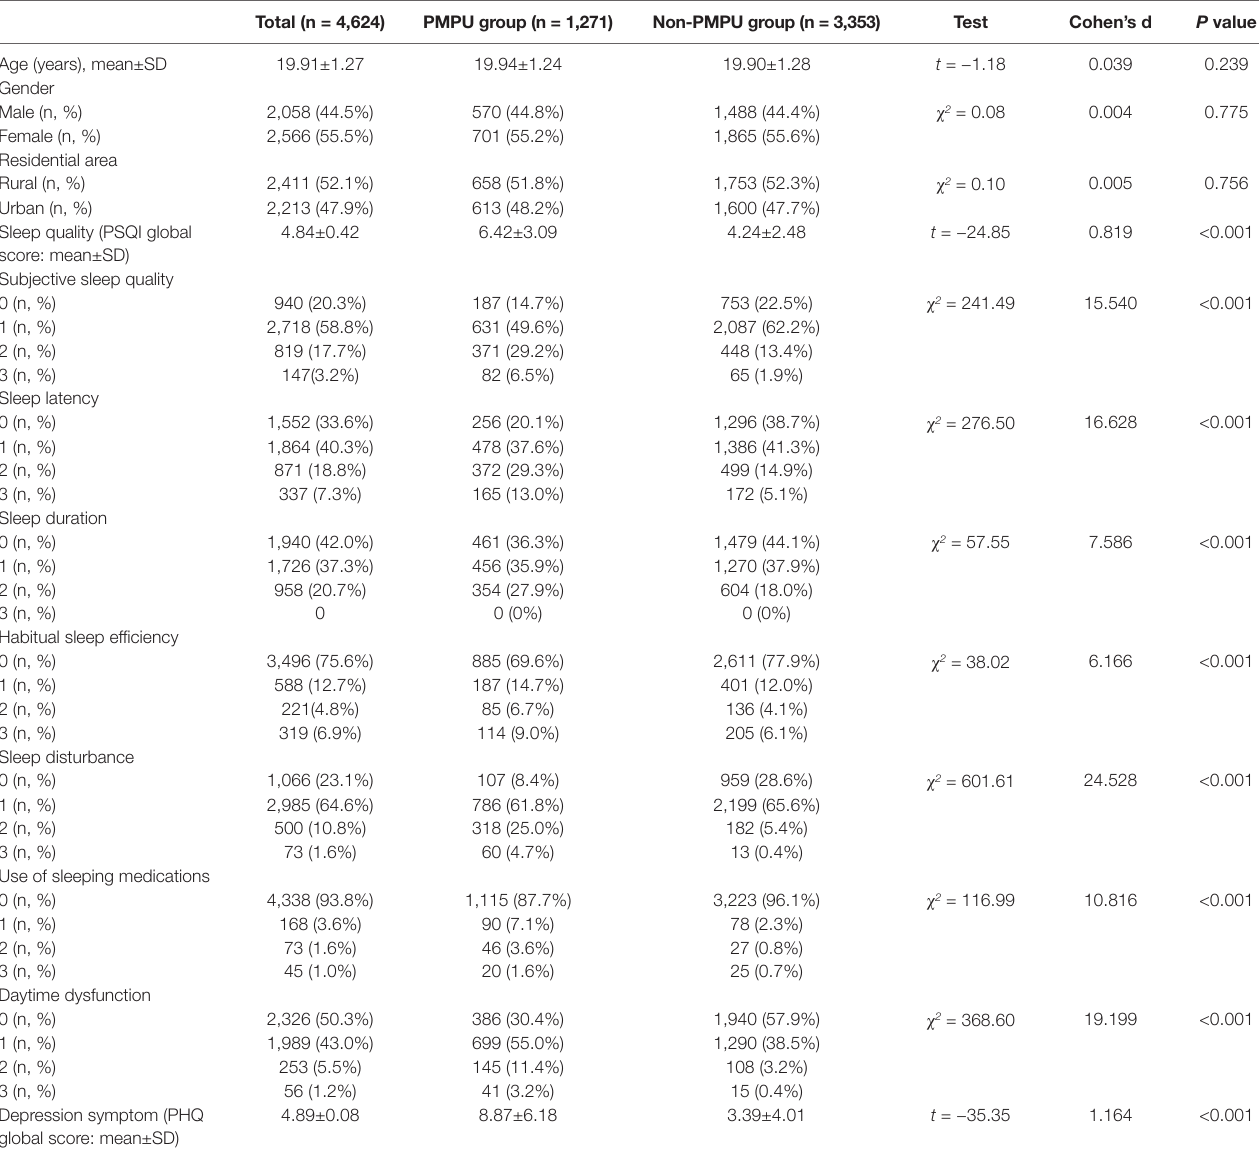
TABlE 1 | Demographic characteristics of adolescents with and without problem mobile phone